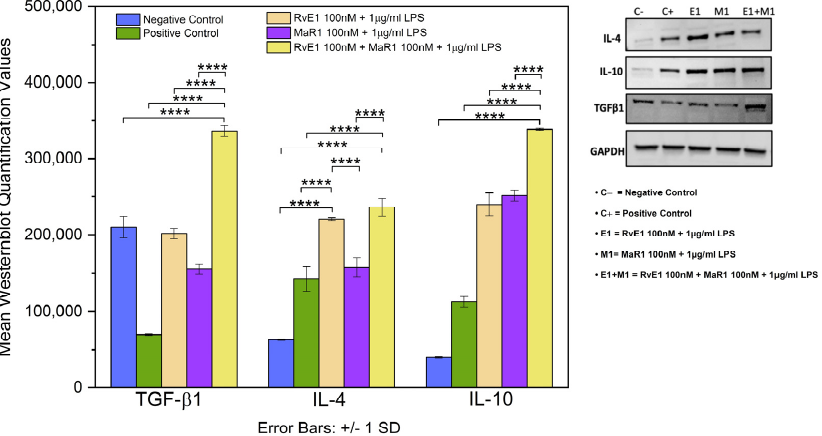
Figure 5. The right panel of the graph shows the expression of IL-4, 1L-10 and TGF- β 1 between the five study groups and the left panel shown the normalized average values of three experimental repeats ( n = 3). The expression of TGF- β 1, IL4 and IL-10 was significantly higher in Group-5 (RvE1 100 nM + MaR1 100 nM + 1 μ g/mL LPS) compared to the other four groups (**** p ≤ 0.0001). 3.6. Western Blot Analysis of RANKL, TNF- α , and IFN- γ Western blot analysis of RANKL, TNF- α , and IFN- γ revealed a high statistical signif- icant difference in the normalized mean values among the five study groups, (F = 44.311, p ≤ 0.0001), (F = 412.596, p ≤ 0.0001), and (F = 64.303, p ≤ 0.0001), respectively. Among the five groups, the mean values of RANKL and TNF- α expression in Group-2 (positive con- trol) were significantly higher than other four groups. The mean values of Group-1 (neg- ative control) and Group-5 (RvE1 100 nM + MaR1 100 nM +1 μ g/mL LPS) were signifi- cantly lower than those of the other three groups (Figure 6). Figure 6 . The right panel of the graph depicts the levels of protein expressions of RANKL, TNF- α , and IFN- γ by Western blot across the five study groups. Positive control has significantly higher RANKL and TNF- expression than the other four groups (Negative control, RvE1 + LPS, MaR1 + LPS, and RvE1 + MaR1 + LPS) ( p ≤ 0.0001). Negative control group and Group 5 (RvE1+ MaR1 + LPS) have comparable levels of expression ( p > 0.05). The left panel represents the normalized average values of three experimental repeats ( n = 3) with their significant expressions. (**** p ≤ 0.0001).